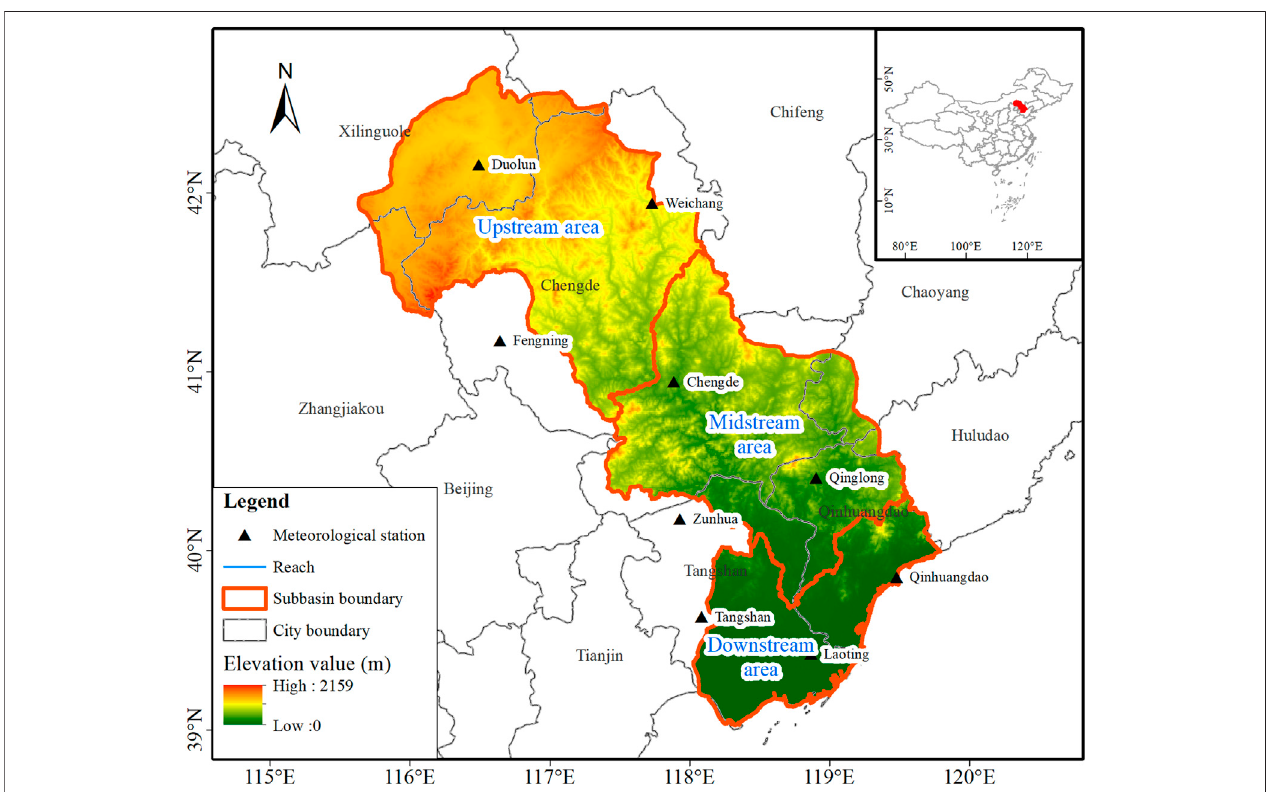
FIGURE 1 | Topography of the study domain and spatial distribution of meteorological